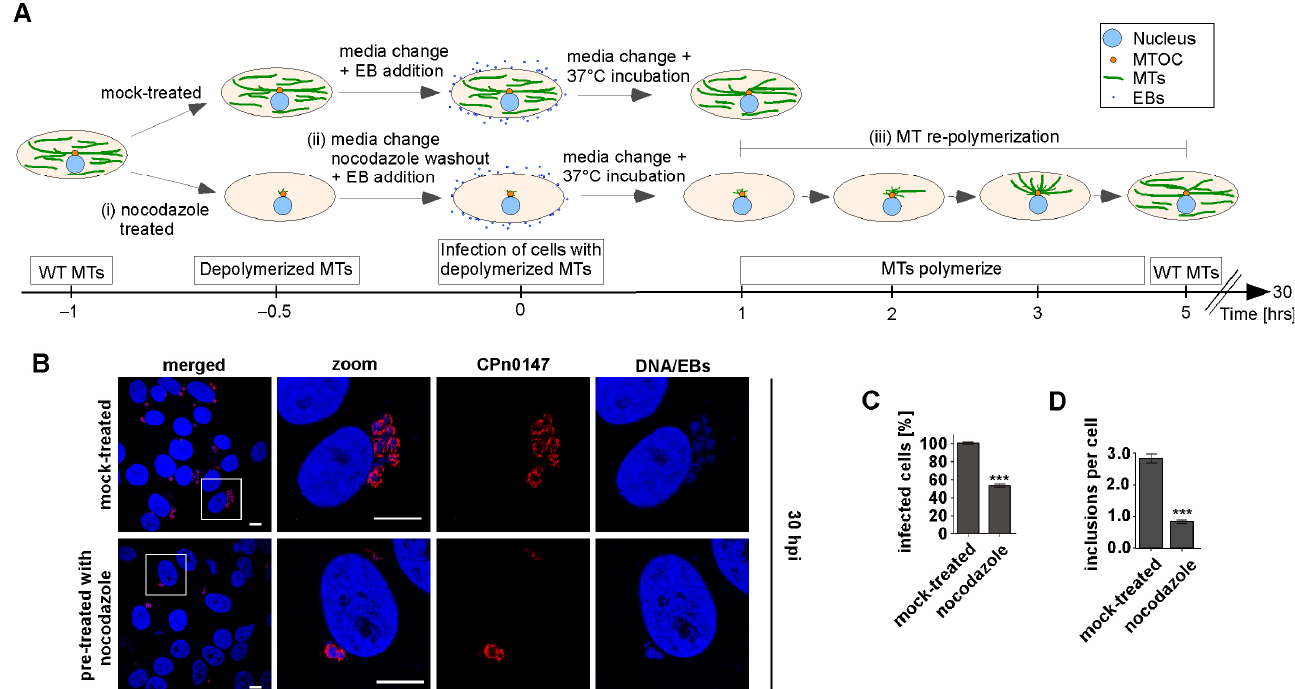
Figure 1. The host MT cytoskeleton was required for chlamydial infection. ( A ) Schematic represen- tation of the experimental setup used: mammalian HEp-2 cells were mock-treated (DMSO-treated, top panels) or treated with the MT-destabilizing drug nocodazole (bo tt om panels) prior to infection with puri fi ed Cpn EBs (MOI = 5) for 30 h. Nocodazole treatment (bo tt om panels) was as follows: (i) cells were incubated with nocodazole for 30 min at 37 °C and MT depolymerization was monitored microscopically. (ii) Nocodazole washout via a media change was followed by infection with Cpn EBs. (iii) Repolymerization of MTs was monitored (Figure S1) and was complete after 5 h. ( B ) Rep- resentative confocal images of mock-treated or nocodazole-treated HEp-2 cells infected with puri- fi ed EBs. Chlamydial inclusions (red) were visualized with an anti-CPn0147 antibody (chlamydial inclusion membrane protein) and DNA (blue) with DAPI. White boxes show enlargements (zoom). Scale bars: 10 µm. ( C ) Quanti fi cation of the number of infected HEp-2 cells. Treatment of cells with/without nocodazole prior to the infection depicted in ( A ). ( D ) Quanti fi cation of the number of chlamydial inclusions per infected HEp-2 cell that were treated with/without nocodazole prior to infection. ( C , D ) three independent experiments/per condition as described in ( A ), each with 100 cells; error bars represent ± SEM; T-test: p < 0.001 (***).